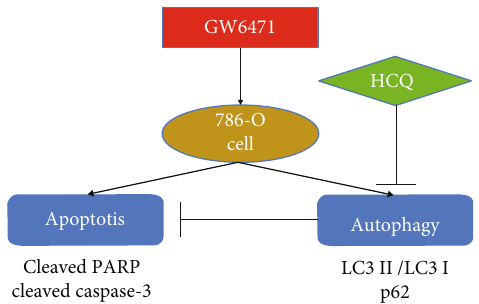
Figure 7: Model of synergistic antitumor e ff ects of GW6471 and hydroxychloroquine in 786-O cells. GW6471 can induce apoptosis and autophagy in 786-O cells. Hydroxychloroquine can inhibit autophagy induced by GW6471 in 786-O cells. Apoptosis can be potentiated in 786-O cells cotreated with GW6471 and hydroxychloroquine compared with being treated GW6471